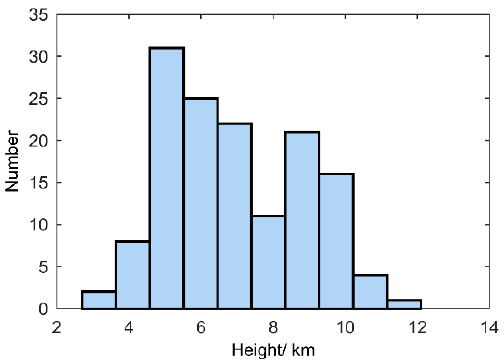
Figure 7. The lightning initiation height distribution is given by a two-station 3-D locating algorithm.